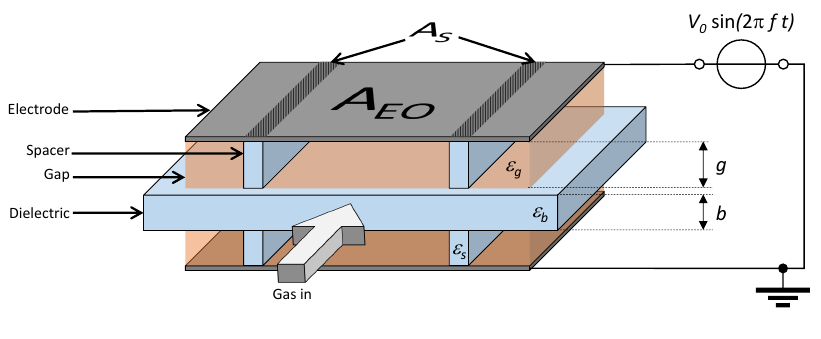
Figure 1. Sketch of the plane parallel volume DBD arrangement with 2 discharge zones each with n =2